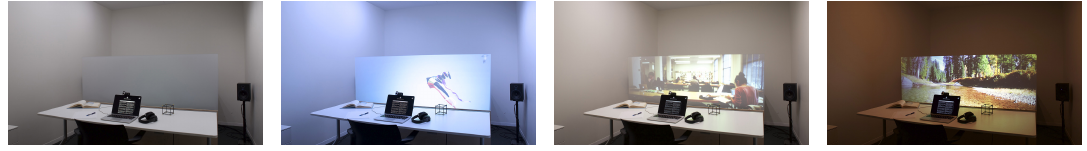
Figure 3. Mediated Atmospheres office space with different